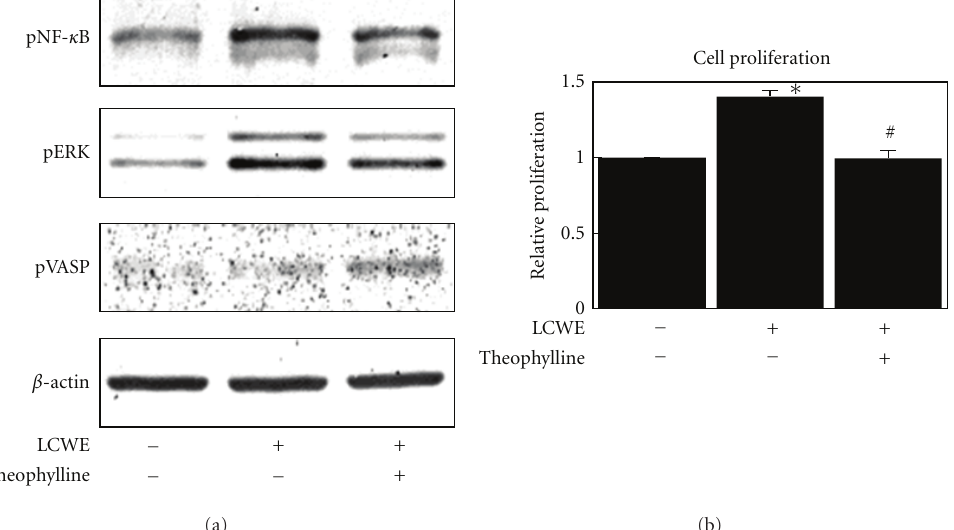
Figure 2: Changes in the levels of phospho-NF- κ B, phospho-ERK, and phospho-VASP (a) and change in cell proliferation (b) in NIH3T3 mouse fibroblast cells after treatment with LCWE (10 μ g/mL) or a combination of theophylline (10mM) and LCWE (10 μ g/mL). Each column represents the mean ± SEM. ∗ P < 0 . 01 versus untreated controls. # P < 0 . 01 versus LCWE treatment group.